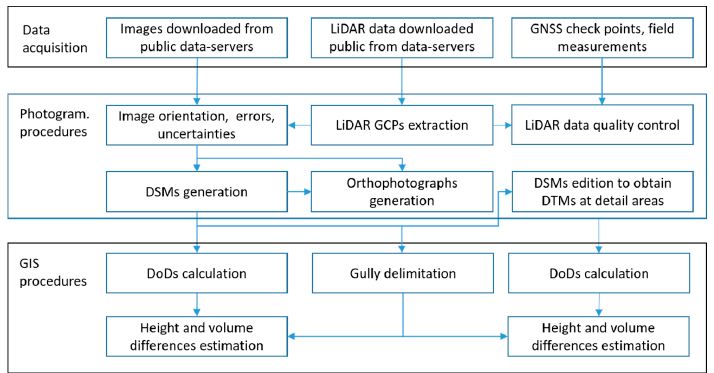
Figure 3. Flow chart of the methodology.